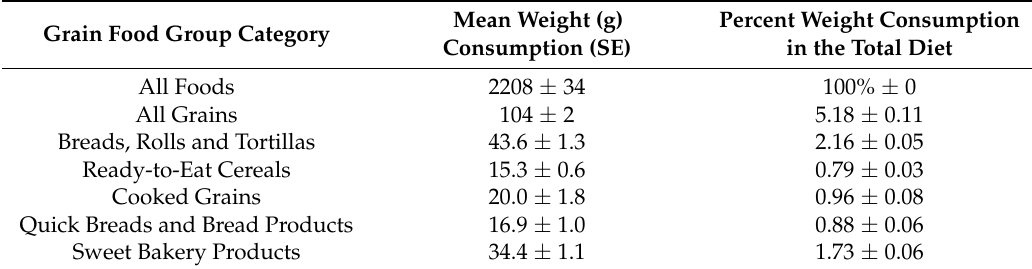
Table 1. Grain categories identified from National Health and Nutrition Examination Survey 2009–2012 in children and adolescents (2–18 years old; N = 6109) by mean ± standard error (SE) gram weight and percent weight (SE) in total